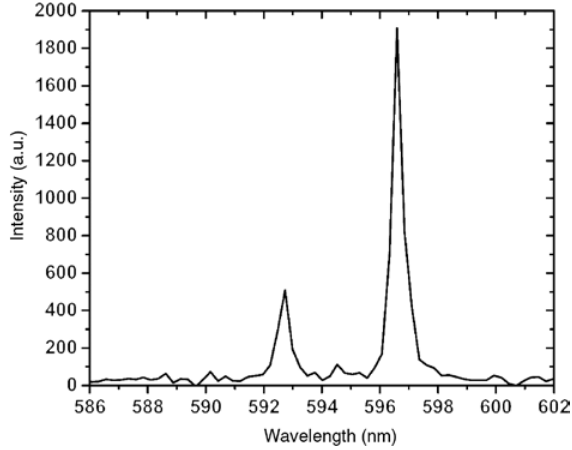
Figure 4: Typical emission spectrum of the